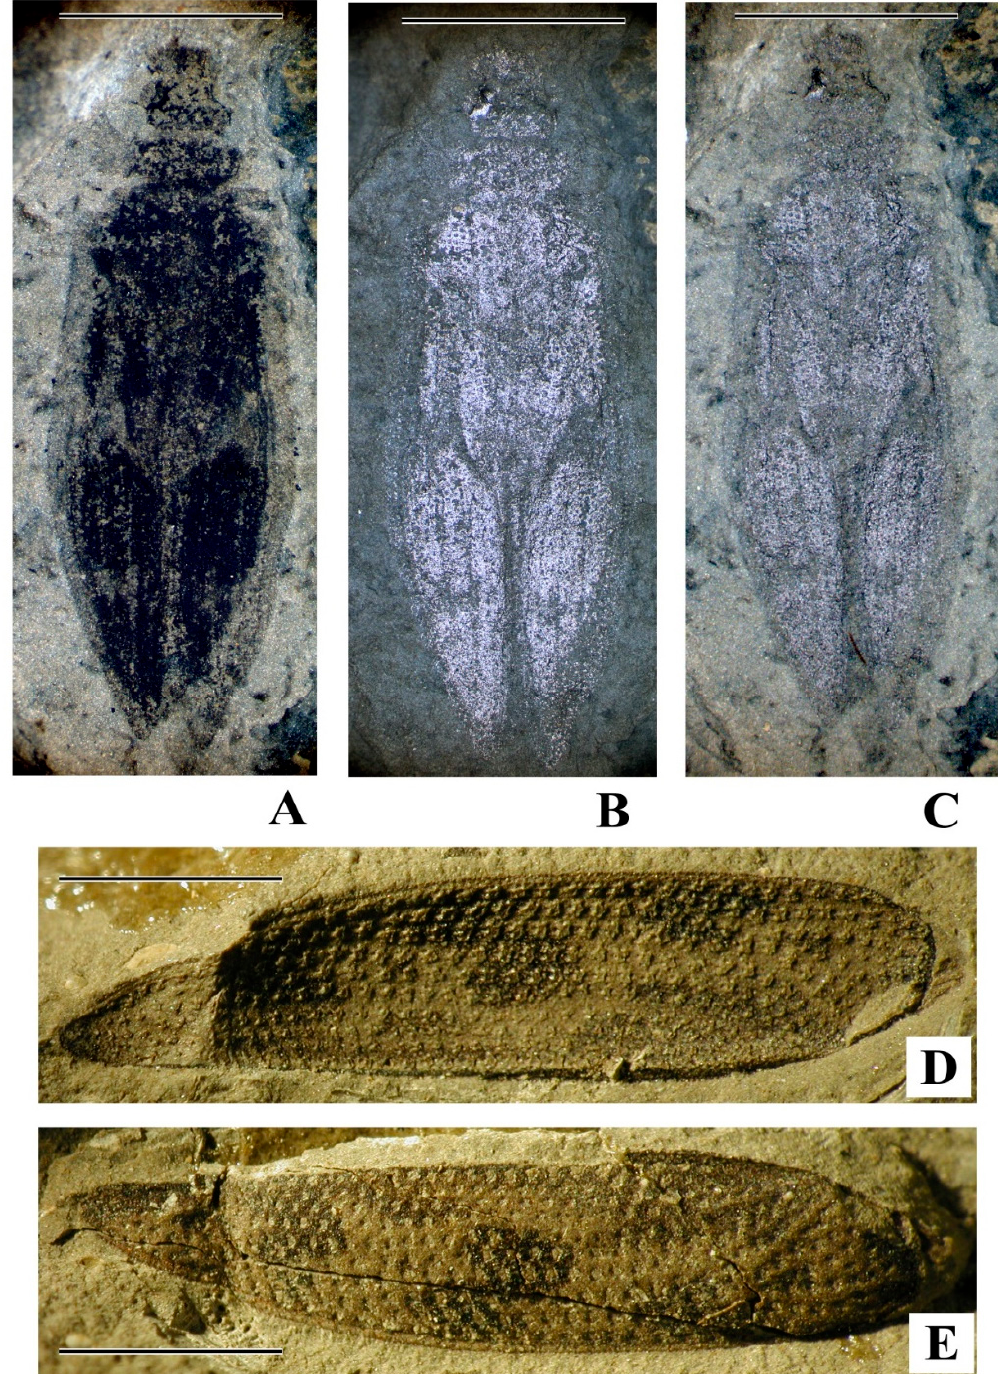
Figure 2. Coleopseidae and Permocupedidae: A–C— Coleopsis archaica , holotype ZfB 3315 (Permian: Asselian-Sakmarian; Saarland, Grügelborn): part, body immersed in alcohol (isopropanol); A —with polarizing filters completely crossed (with linear polarized light completely extinct); B —without polarizing filters; C —with polarizing filters approximately halfway crossed; length of print 7.8 mm, scale bar = 2.5 mm; from http: // www.zin.ru / Animalia / Coleoptera / rus / coleopsi.htm. D – E — Tatarocupes granulatus , holotype PIN 3700-34 (Permian, Guadalupian / Lopingian, Capitanian / Wuchiapingian; Orenburg Region, Novo-Aleksandrovka): D —counterpart, E —part; length of print 8.0 mm, scale bar = 2.0 mm; from http: // www.zin.ru / Animalia / Coleoptera / rus /